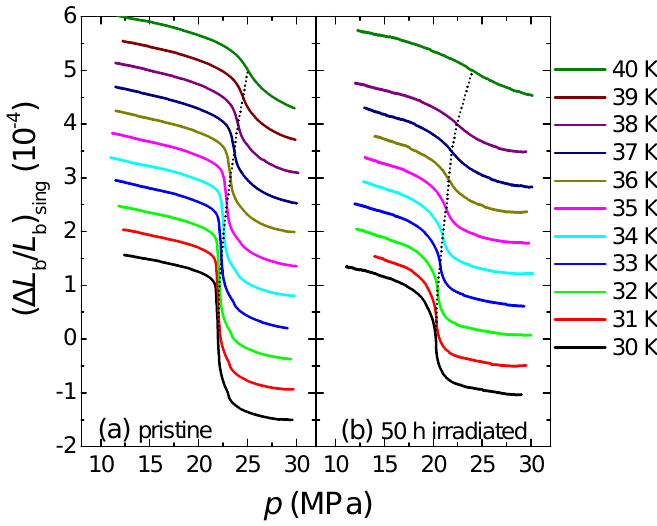
Figure 1. Singular part of the relative length change ( ∆ L b / L b ) sing of κ -(BEDT-TTF) 2 Cu[N(CN) 2 ]Cl (batch #AF063) in its pristine form (data taken from Ref. [25]) ( a ) and after exposure to X-ray irradiation for 50h ( b ). Data were taken along the out-of-plane b axis as a function of pressure p at constant temperatures between 30K and